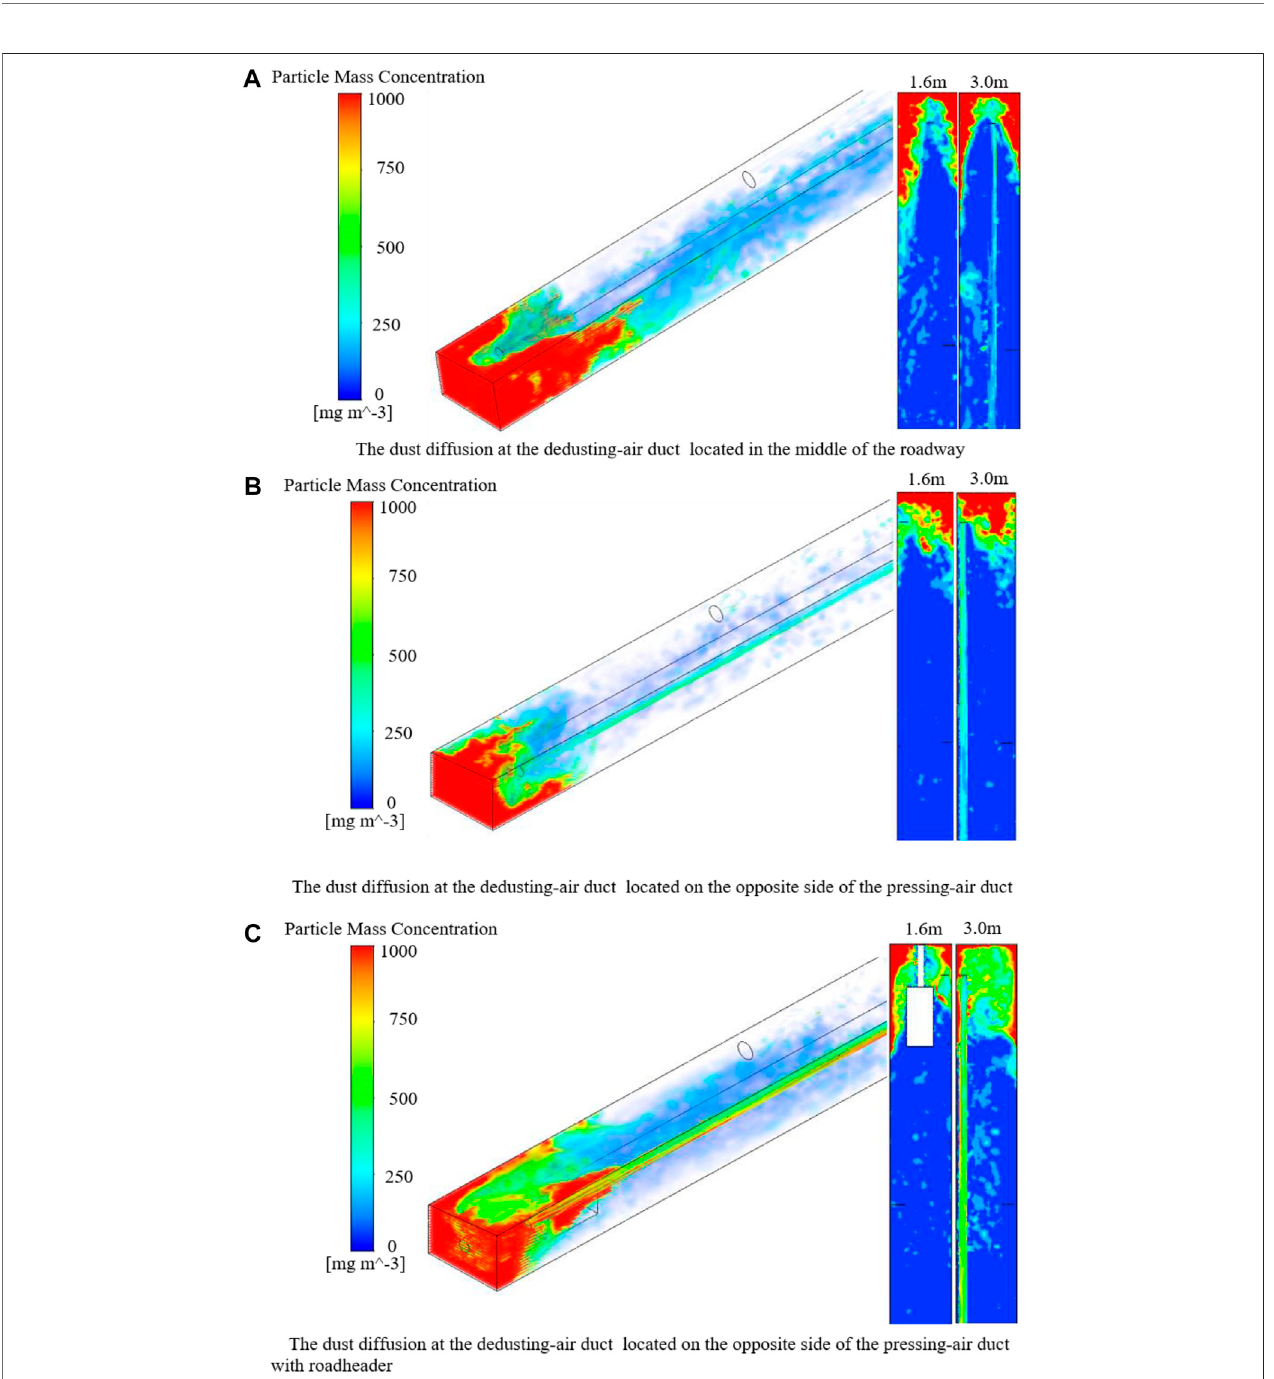
FIGURE 9 | Dust diffusion for different dedusting-air duct positions: (A) in the middle of the roadway; (B) on the opposite side of the pressing-air duct; (C) on the opposite side of the pressing-air duct with roadheader.